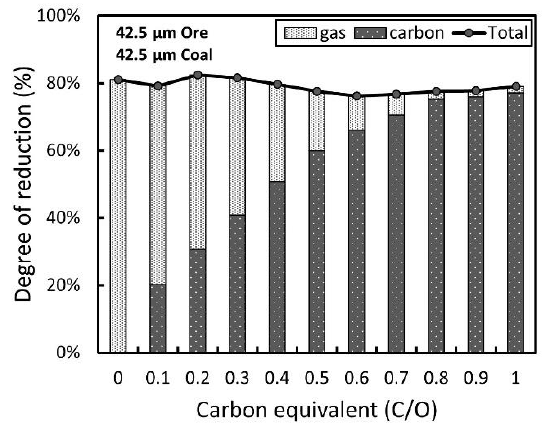
Figure 7. Relationship of the degree of reduction and the carbon equivalent.